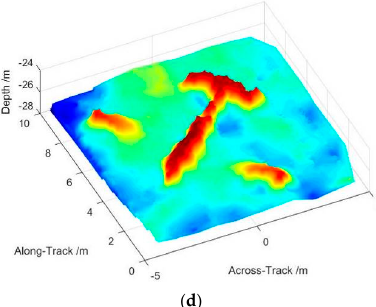
Figure 8. Complex geometry target simulation: ( a ) original grayscale image of airplane; ( b ) highlights generated from SFS method; ( c ) imaging result of CBF with stripes; and ( d ) imaging result of accelerated deconvolved beamforming.